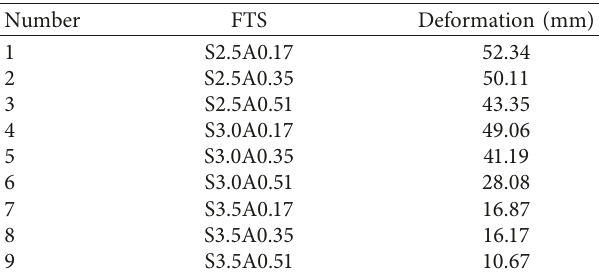
Figure 19: Deformations of FTS. (a) S2.5A0.17, (b) S2.5A0.35, (c) S2.5A0.51, (d) S3.0A0.17, (e) S3.0A0.35, (f) S3.0A0.51, (g) S3.5A0.17, (h) S3.5A0.35, and (i) S3.5A0.51. Table 7: Deformation distance of